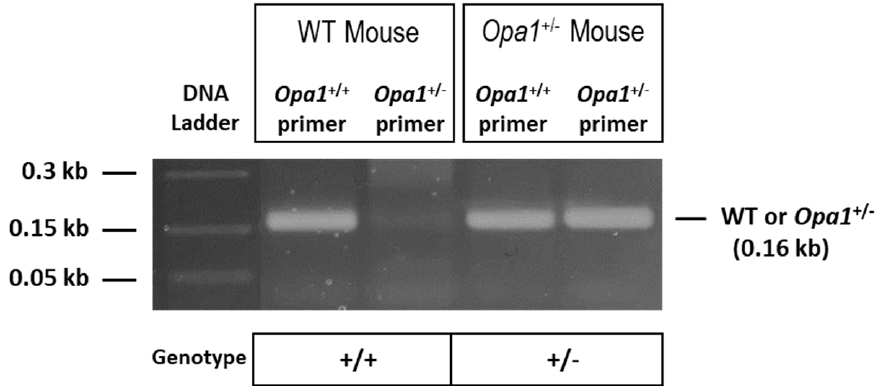
Figure 1. PCR analysis using mice tail tip DNA indicating genotypes of Opa1 heterozygous knockout ( +/ − ) and wild-type (WT) mice. The wild-type Opa1 allele ( Opa1 +/+ ) and the disrupted allele ( Opa1 +/ − ) are both represented by a band at 0.16kb.